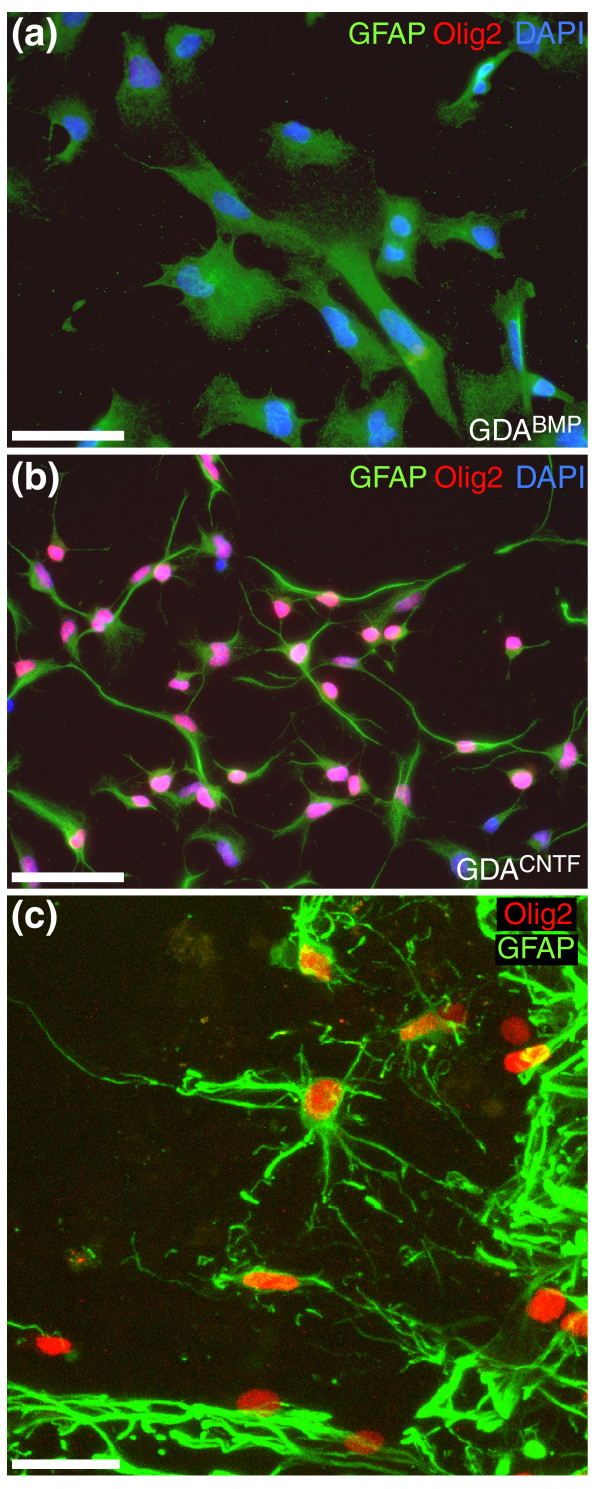
Differential expression of Olig2 protein by different astrocyte populations. (a) GDAsBMP do not express Olig2. (b) In sharp contrast, GDAsCNTF are uniformly immunopositive for Olig2 in vitro. (c) A subset of endogenous GFAP+ astrocytes in the margins of untreated dorsal column spinal cord injuries is also Olig2-immunoreactive. Survival, 8 days post-injury. Note the nuclear localization of Olig2 in GDAsCNTF in vitro and in reactive, endogenous GFAP+ astrocytes in vivo. Scale bars: (a,b) 50 μm; (c) 25 μm.